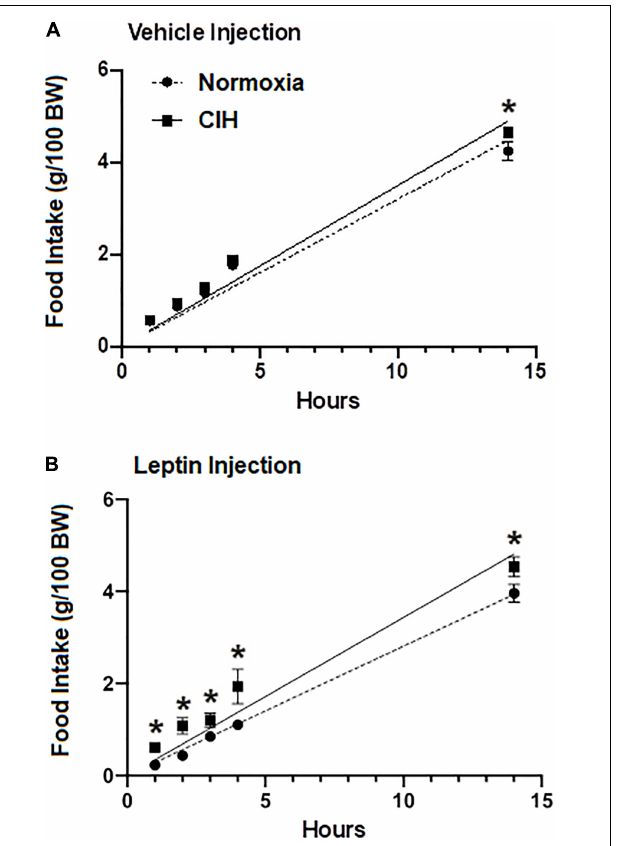
FIGURE 5 | Line graphs showing food intake at 1, 2, 3, and 14 h post-injection (ip) of either 40 ng/kg in 1 ml (range; 14.8–19.1 ng ml) leptin ( n = 12; n = 6 for each normoxic and CIH group) (A) or the vehicle ( n = 11; n = 5 for each normoxic and n = 6 for CIH group) (B) . Note that leptin induces satiety in the normoxic group, but not in the CIH exposed group. Data are presented as mean ± standard error. * p <